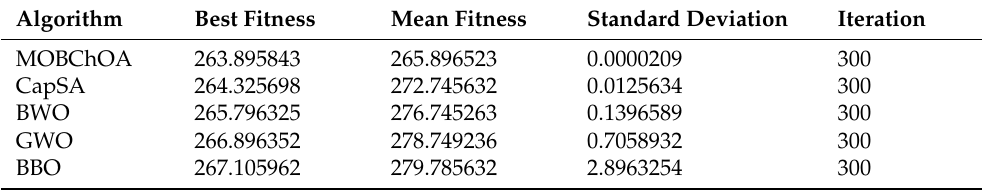
Figure 10. The convergence trends of the algorithms for the spring system problem. 50